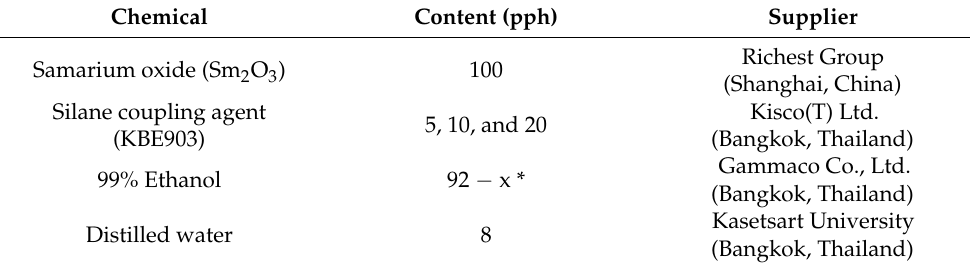
Table 3. Formulations for surface treatment of Sm 2 O 3 particles and their